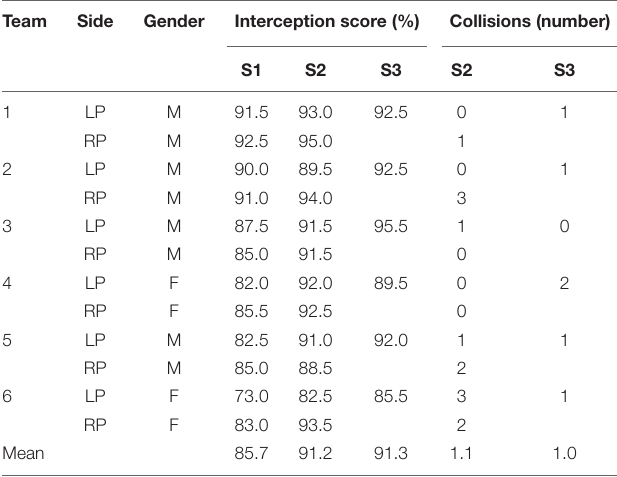
TABLE 1 | Interception scores of the 12 individual participants in Sessions 1 (S1) and 2 (S2) and the six teams in Session 3 (S3), together with the number of collisions observed in Sessions 2 and